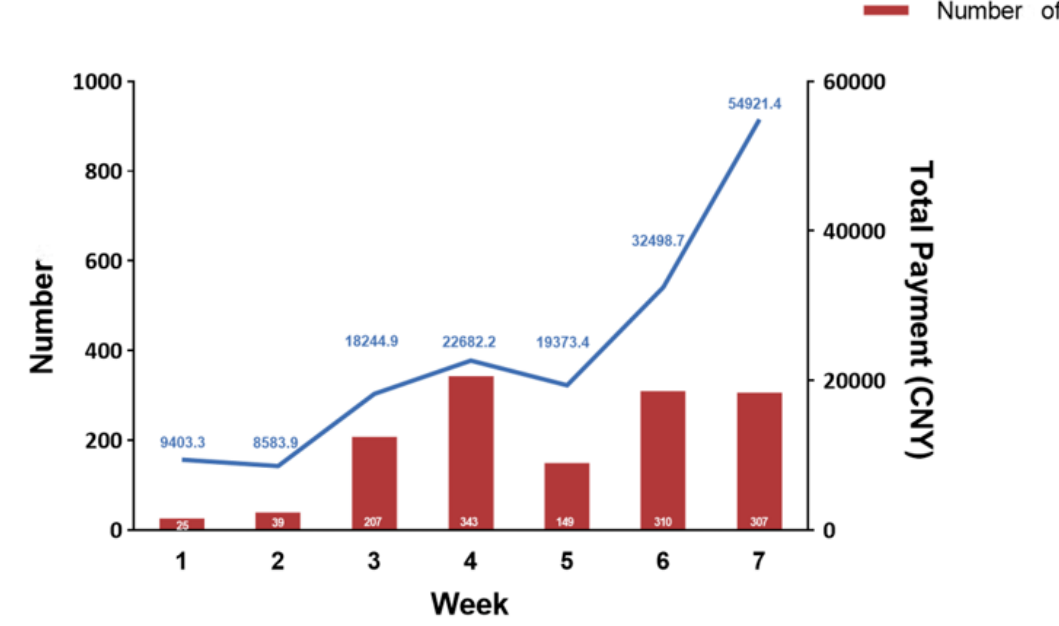
Figure 2. The number of and total payments pertaining to online